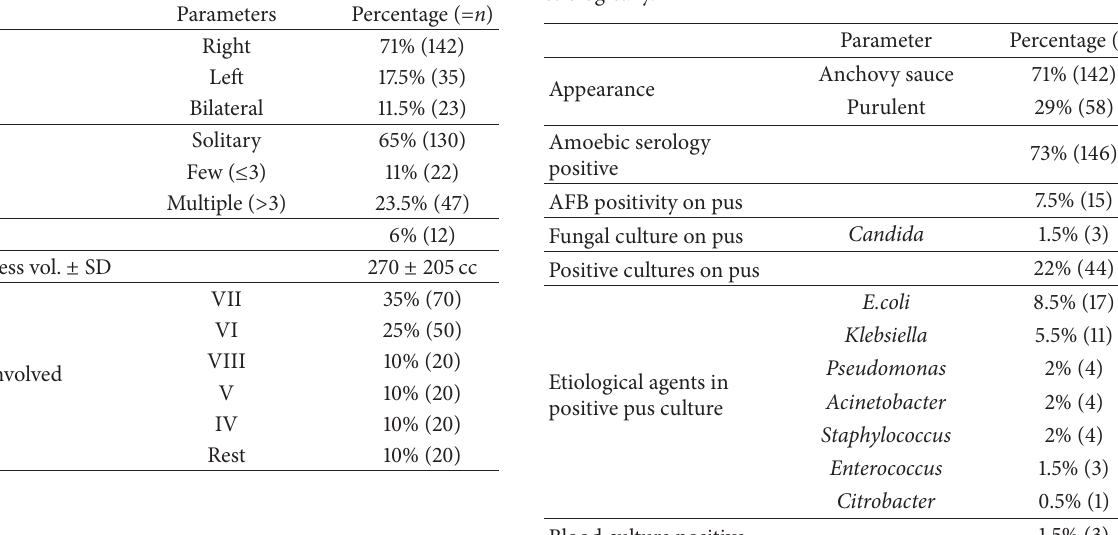
Table 5: Etiological analysis: amoebic serology was positive in 73% patients and, in accordance, aspirate was anchovy sauce in 71% of them. All cases of diagnosed tubercular abscess were AFB